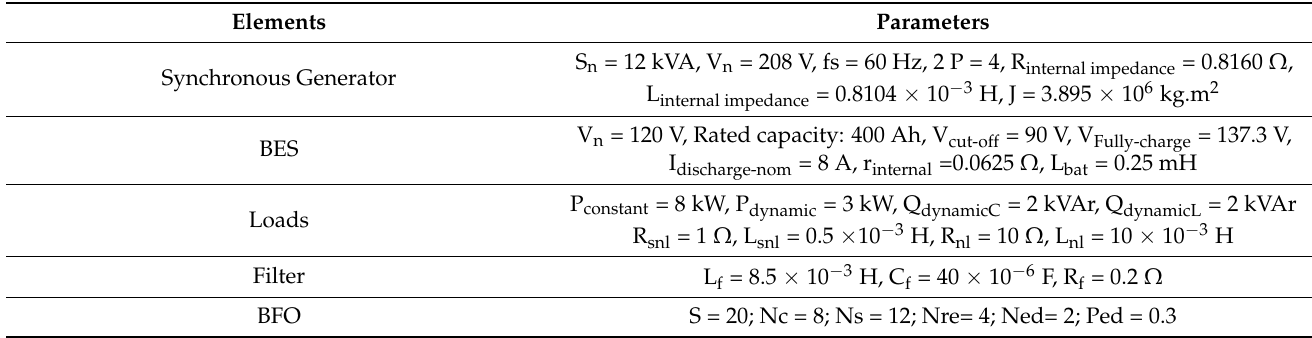
Table A1. Parameters of the